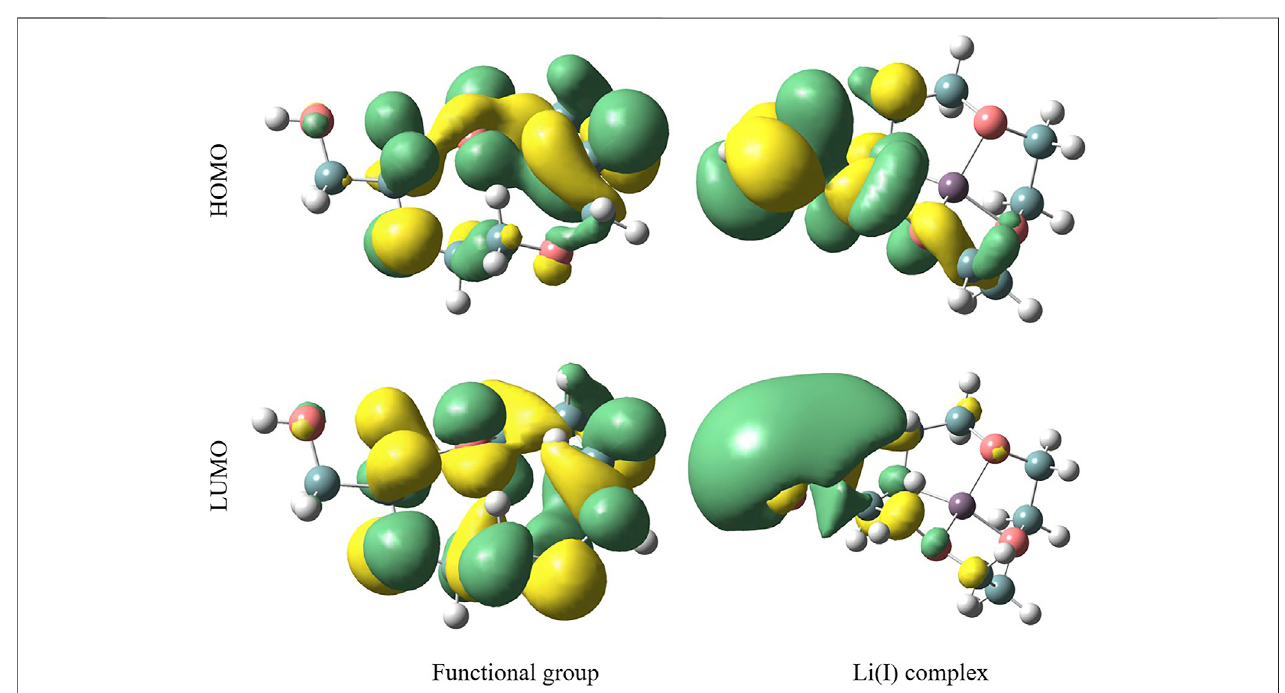
FIGURE 12 | HOMOs and LUMOs before and after the adsorption of PAN-CE@SiO 2 for Li(I).